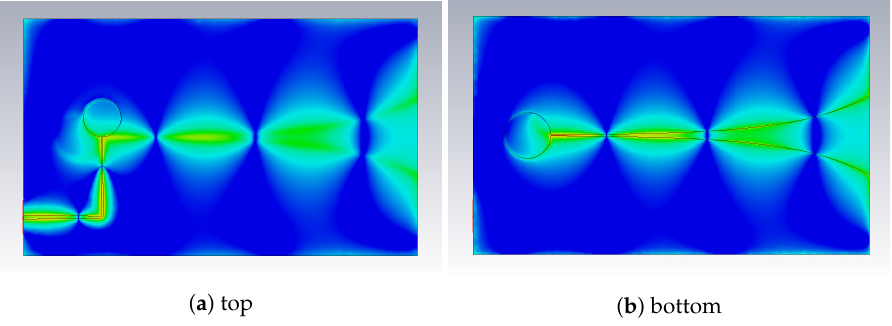
Figure 10. Simulated E-field on the antenna